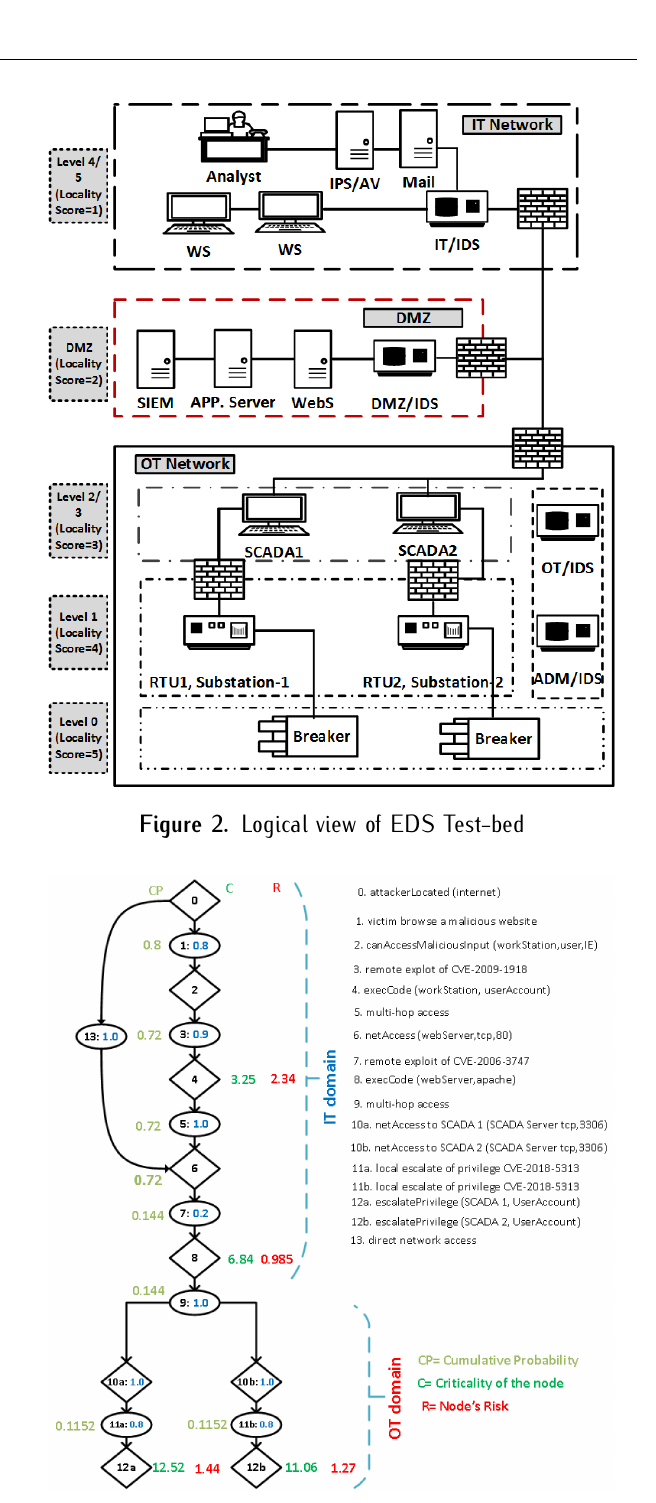
Figure 3. The AG of test-bed based